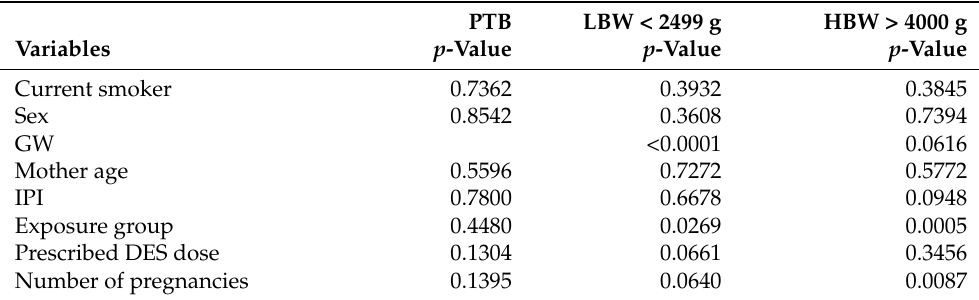
Table 4. Multivariate modeling of PTB, LBW, and HBW in G1